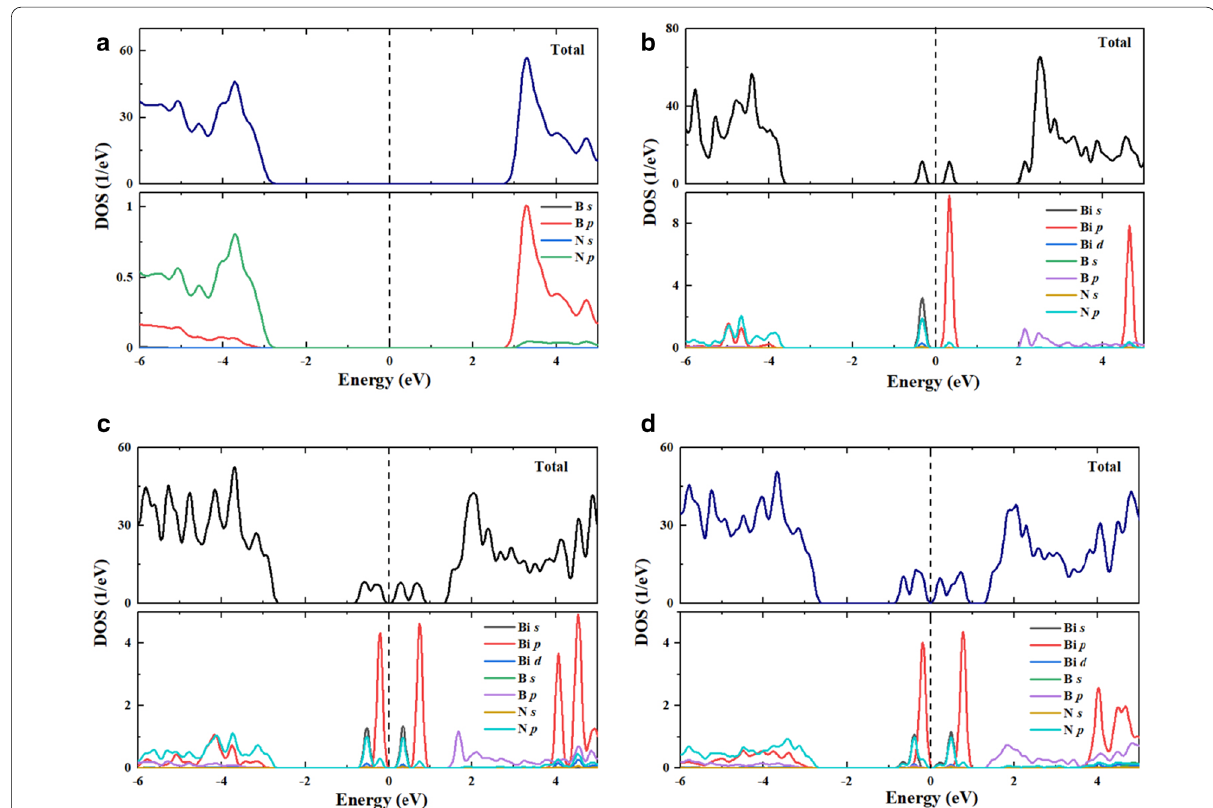
Fig. 5 Calculated total and projected DOS of a pristine BN and Bi‑doped BN monolayers with concentrations, b 2.04%, c 4.08%, and d) 6.1%